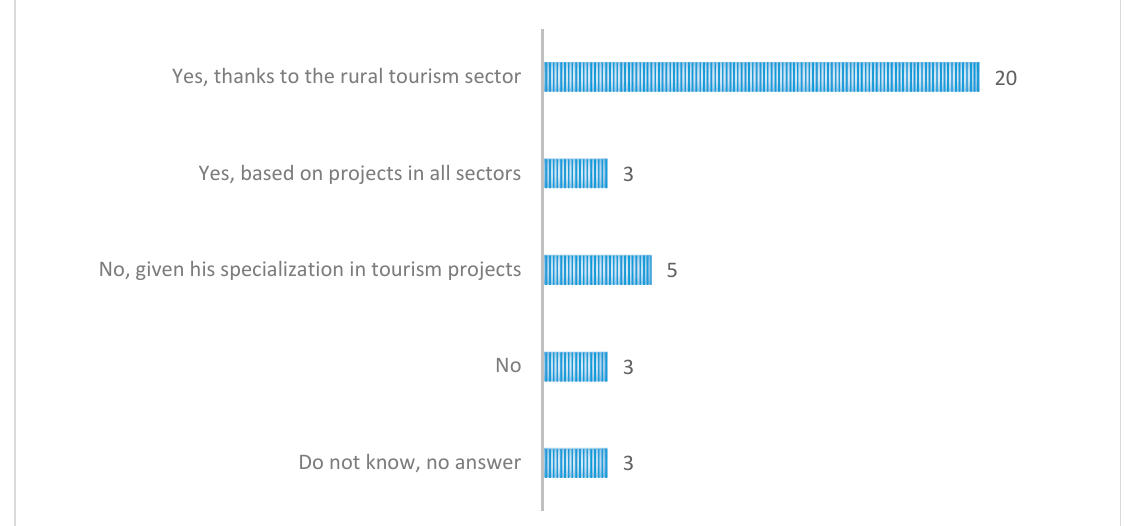
Figure 4. Do you think Proder has contributed to the economic diversification of the region? Through which sectors? Source: Own elaboration.